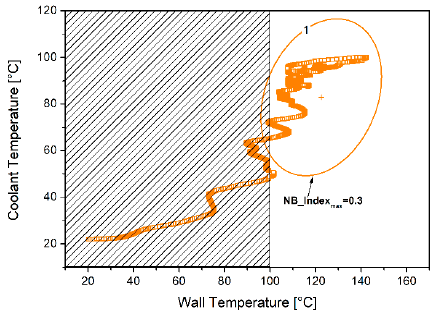
Figure 9. Control region and system trajectory during the NEDC for low boiling levels .